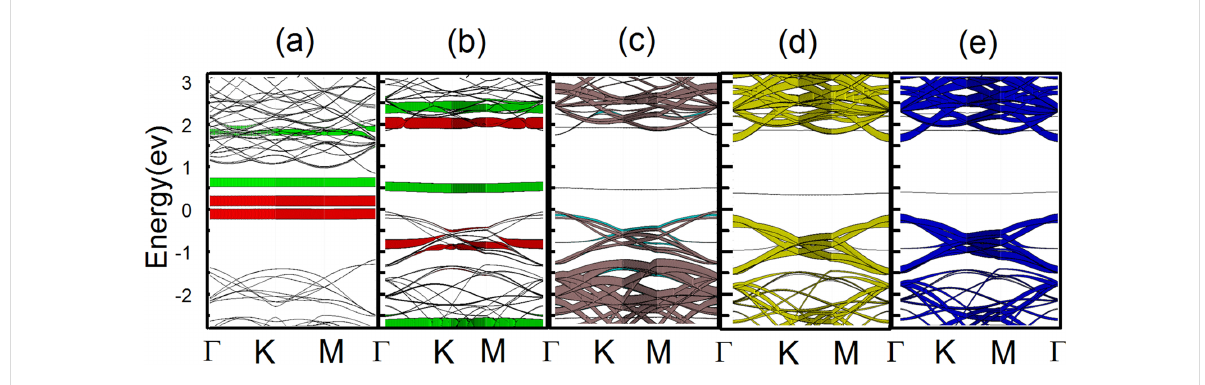
Figure 3: Spin orbital-resolved band structures for WS 2 with (a) adsorbed NO and (b–e) adsorbed NO 2 . The red and green lines represent the contri- butions from the spin-up and spin-down p-orbitals of N and O atoms. Cyan lines and brown lines represent the contributions from the spin-up and spin-down p-orbitals of S atoms. Yellow lines and blue lines represent the contributions from the spin-down and spin-up orbitals of W atoms. The Fermi level is set to the energy zero